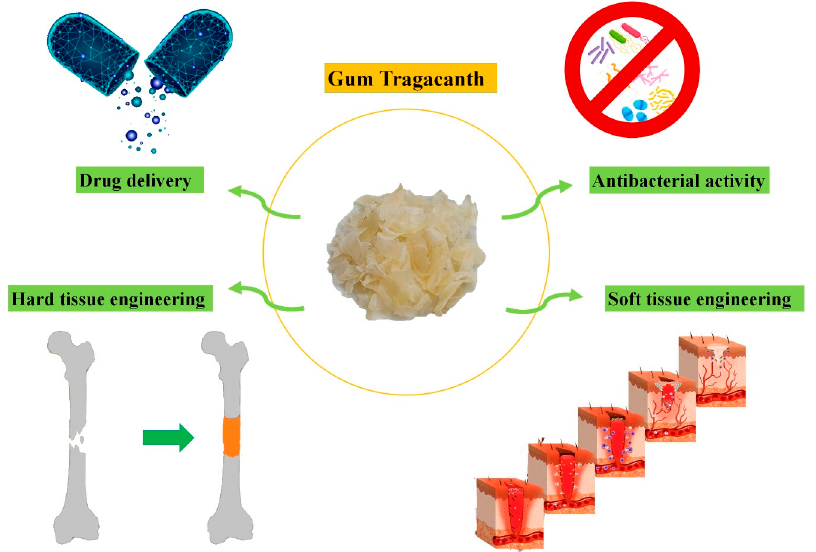
Figure 1. GT offers excellent opportunities for biomedical applications regarding its appropriate physicochemical and biological properties. This natural substance is now being applied for a broad range of applications, from drug delivery strategies to hard and soft tissue engineering.